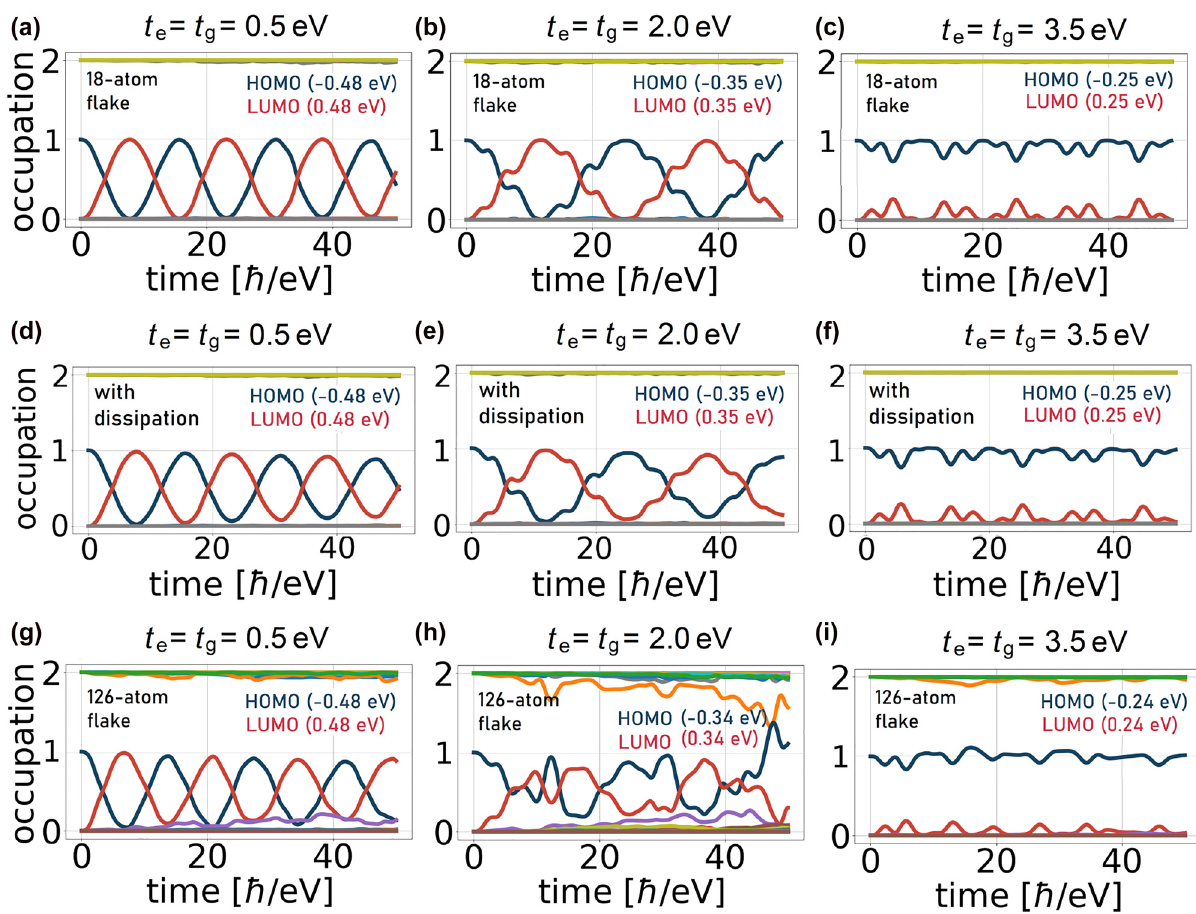
Figure 9: Occupation dynamics for the hybrid system illuminated at a frequency resonant to the HOMO–LUMO transition. This time, the Coulomb interaction is